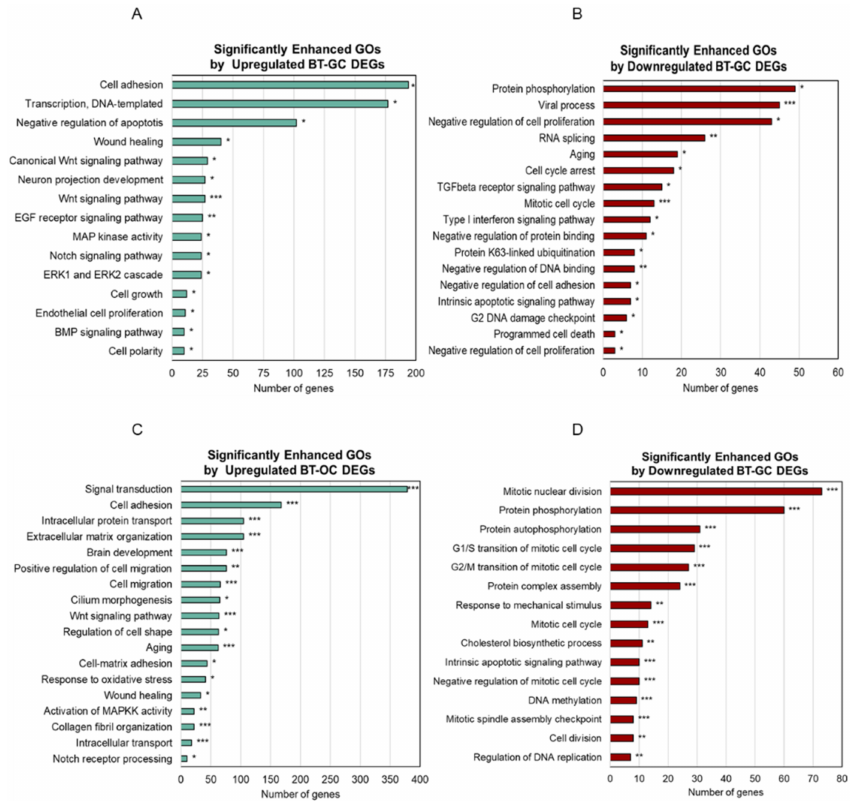
Figure 2. Significantly enriched biological processes of BT-GC and BT-OC DEGs. ( A ) Summary of the top significantly enriched gene ontologies (GO) by the upregulated DEGs of BT-GC. ( B ) The most significantly enriched GOs by the downregulated DEGs of BT-GC. ( C ) Summary of the most signifi- cantly enriched GOs by the upregulated DEGs of BT-OC. ( D ) The most significantly enriched GOs by the downregulated DEGs of BT-OC. Analysis was performed using the Database for Annotation, Visualization, and Integrated Discovery ver.6.8 (DAVID). * Statistically significant ( p -value ≤ 0.05), ** statistically significant ( p -value ≤ 0.01), *** statistically significant ( p -value ≤